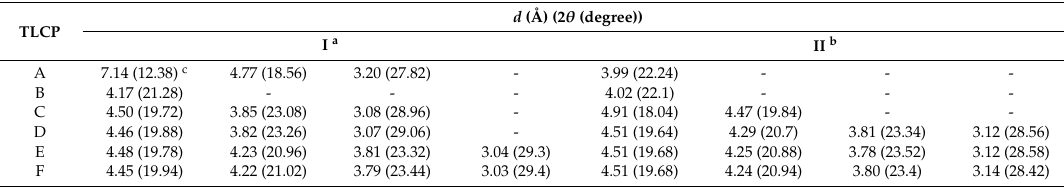
Figure 6. XRD patterns of TLCP-I and TLCP-II series. Table 4. d values corresponding to the XRD peaks of the